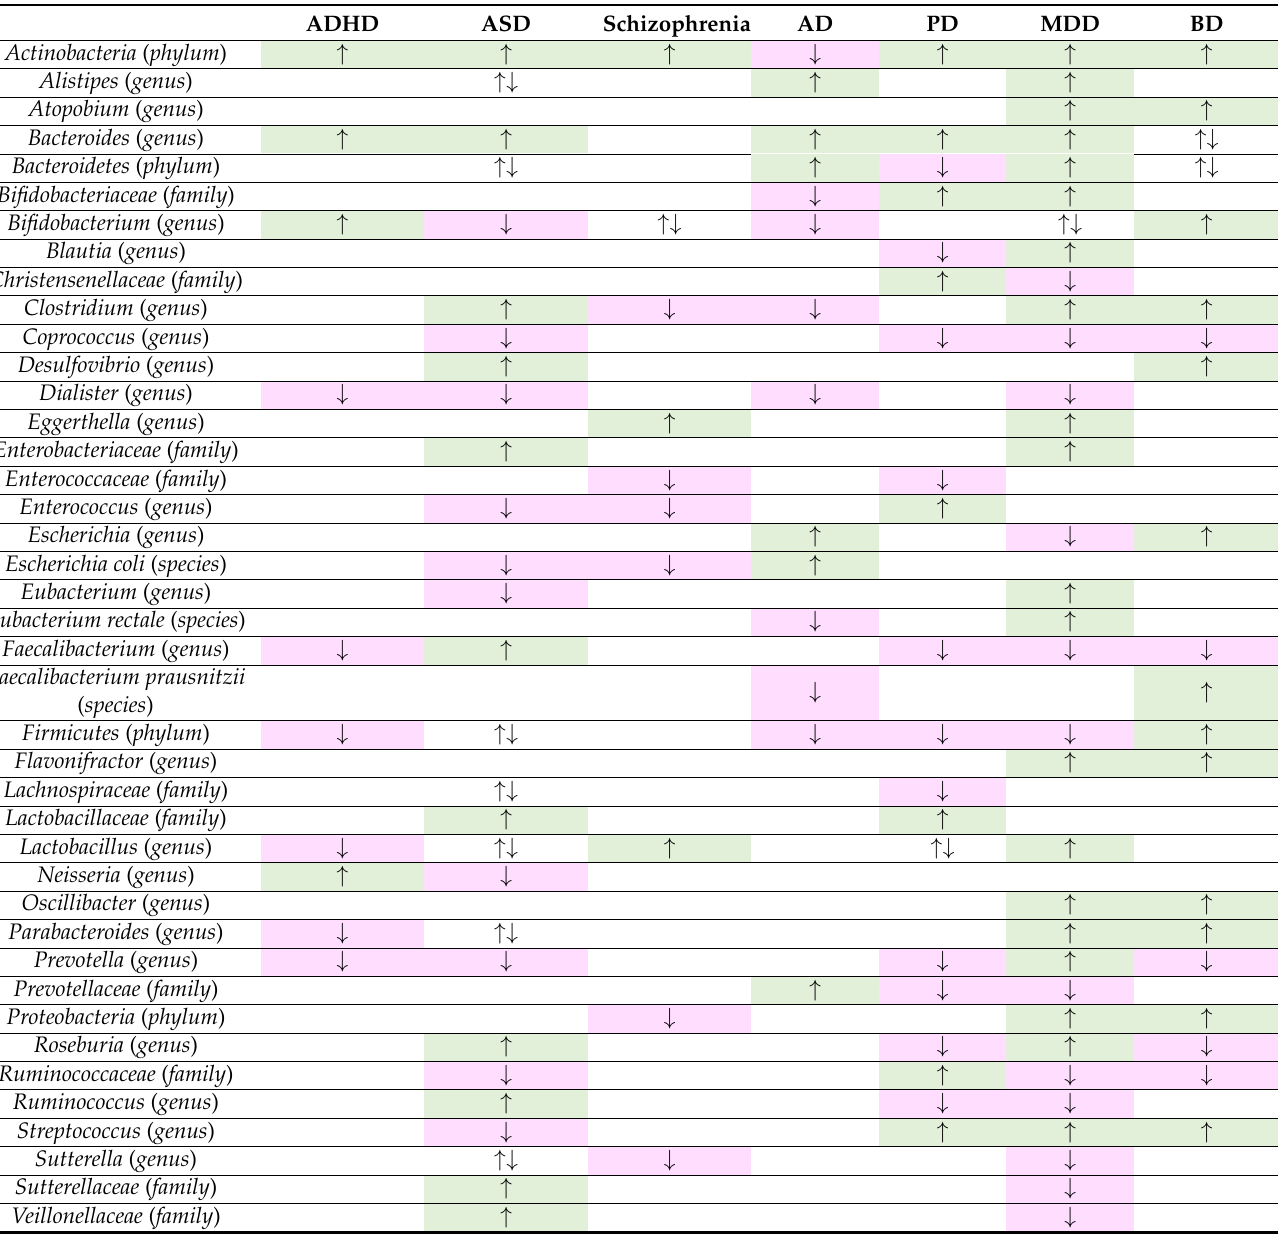
Table 9. Arrangement of the data collected for the individual disorders, allowing to compare the changes in bacteria strains found. The list contains the strains of bacteria along with their taxonomic level in brackets, where an overlap could be observed. An increase in abundance is depicted by light green cells containing “ ↑ ”. Light red cells with “ ↓ ” mark a decrease in the corresponding bacteria strain. “ ↑↓ ” means that data pointing in both directions could be found. The bacterial strains were included in this table regardless of the level of significance in the original literature. For the sources and levels of significance, please consult the corresponding bacteria tables in the previous